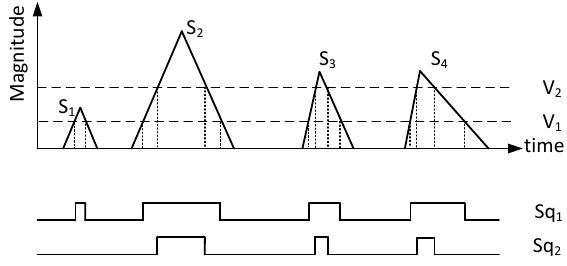
Figure 11. Data acquisition theory of the level scanning method.